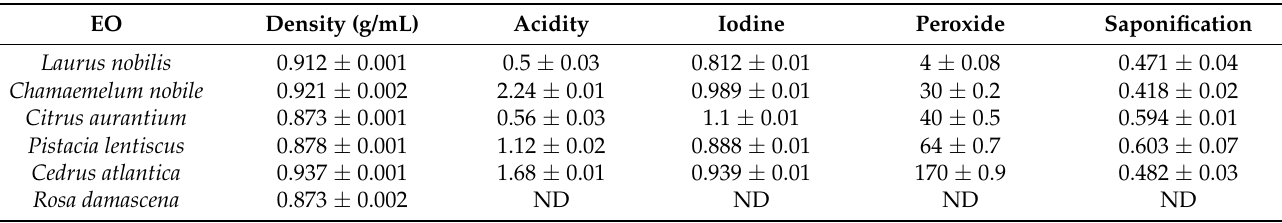
Table 12. Quality control of the EOs of plants species